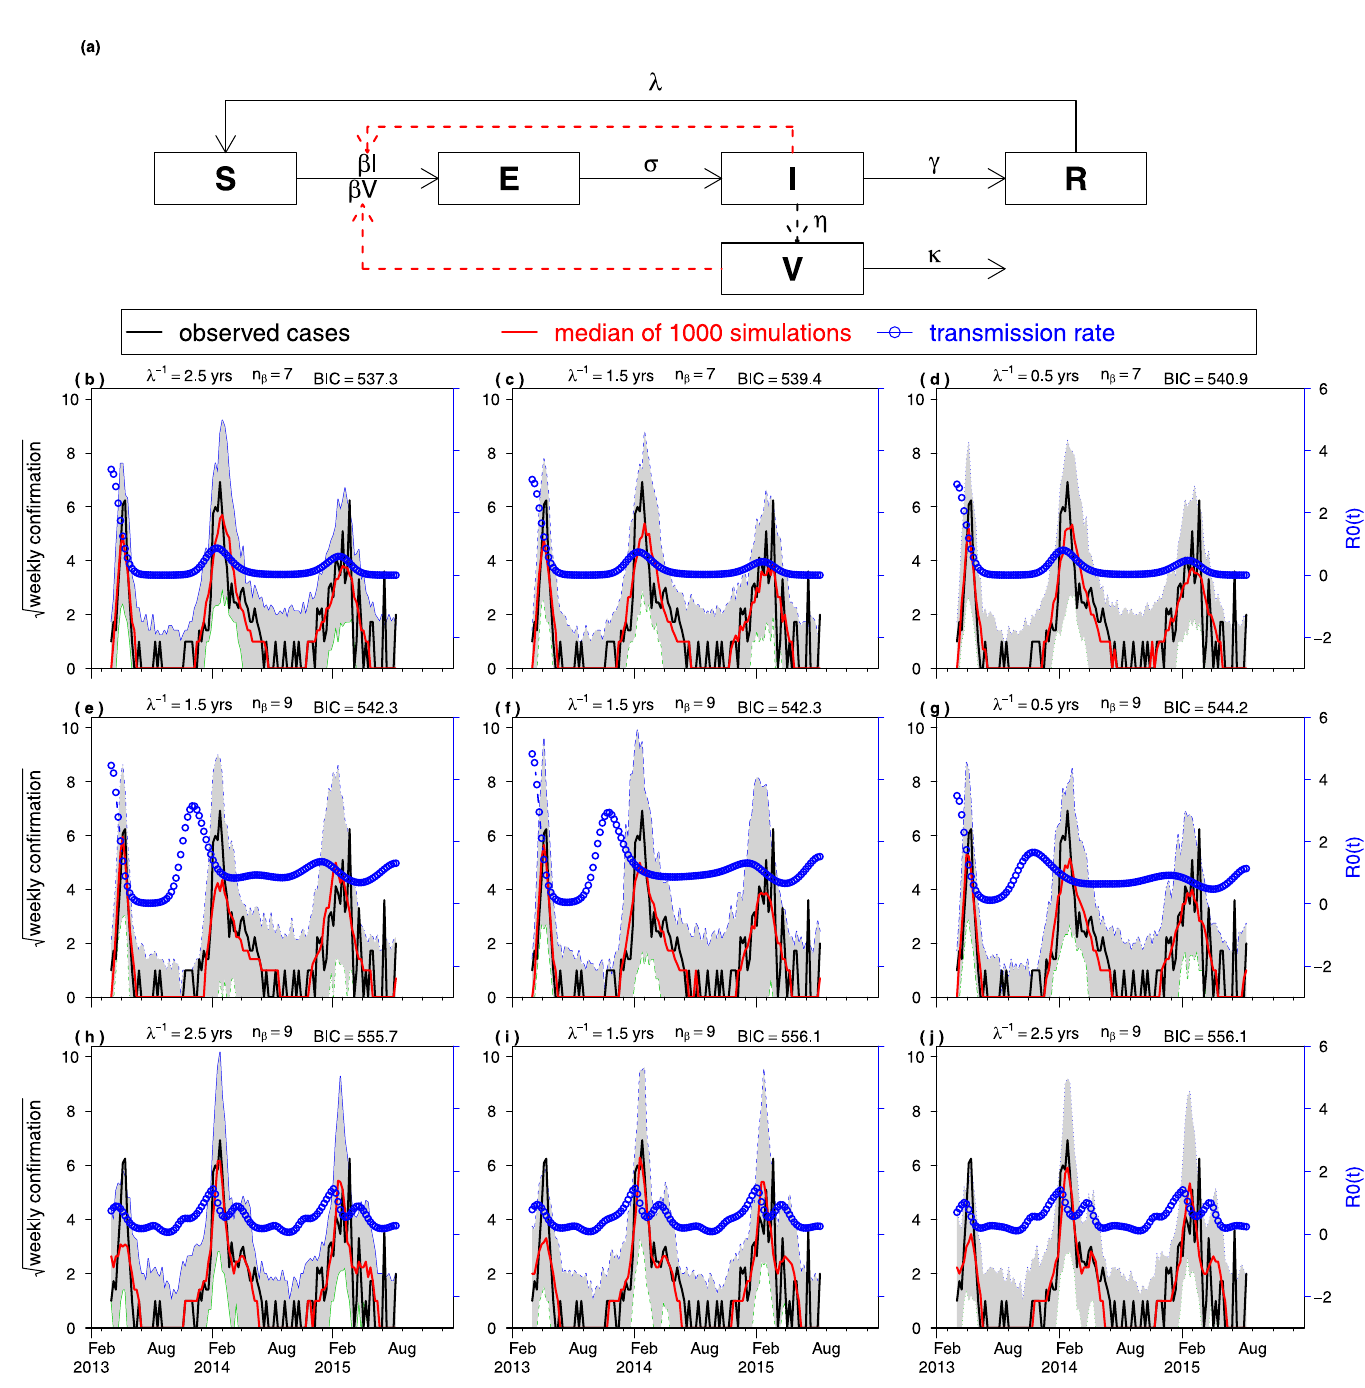
Fig 3. Fitting an SEIRVS model to the weekly human cases of avian H7N9 in China. (a) Model Structure. (b-g) Fitting results with different parameter settings. We computed AICc for a range of λ at 0.5, 1.5 and 2.5 years respectively and the range of nodes from 7 to 14. We display the results of the three models with the smallest AICc. (b-d) non-periodic model with an environmental class, (e-g) non-periodic model without an environmental class, and (h-j) periodic model with an environmental class. The model fit became worse in (e-j), as reflected in the AICc . Larger AICc implies poorer fit.